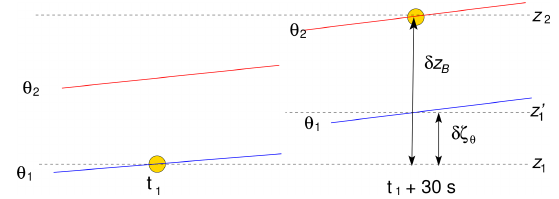
Figure 5. Schematic of the vertical displacement of an SPB. Be- tween the measurement times t 1 and t 1 + 30s, the vertical displace- ment of the SPB is δz B , and the vertical displacement of the isen- tropic surface is δζ θ .